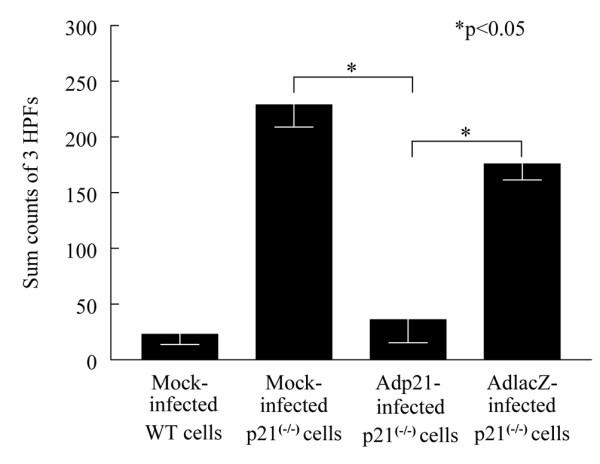
Restoration of p21 in p21(-/-) fibroblast-like synoviocytes (FLS) significantly reduces excessive migration to rheumatoid arthritis (RA) synovial fluid (SF). Cells were infected as described and used for chemotaxis the following day, when nearly all FLS were estimated to express their recipient transgene. Three high powered fields (HPFs) of migrated cells were counted and their sum was determined for each well. Bars represent the mean of quadruplicate wells ± standard error (SE) and an asterisk indicates a statistically significant difference. These data are representative of three independent assays. AdlacZ, adenovirus expressing β-galactosidase; Adp21, adenovirus expressing p21; WT, wild type.